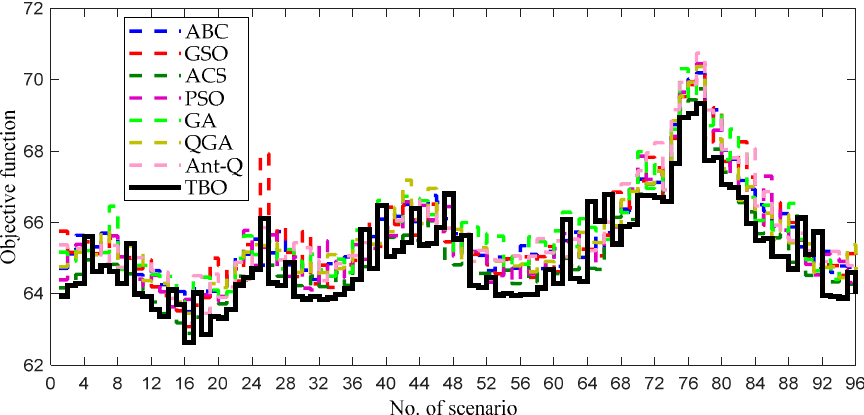
Figure 11. Optimal objective function of the IEEE 118-bus system obtained by different algorithms in 10 runs.